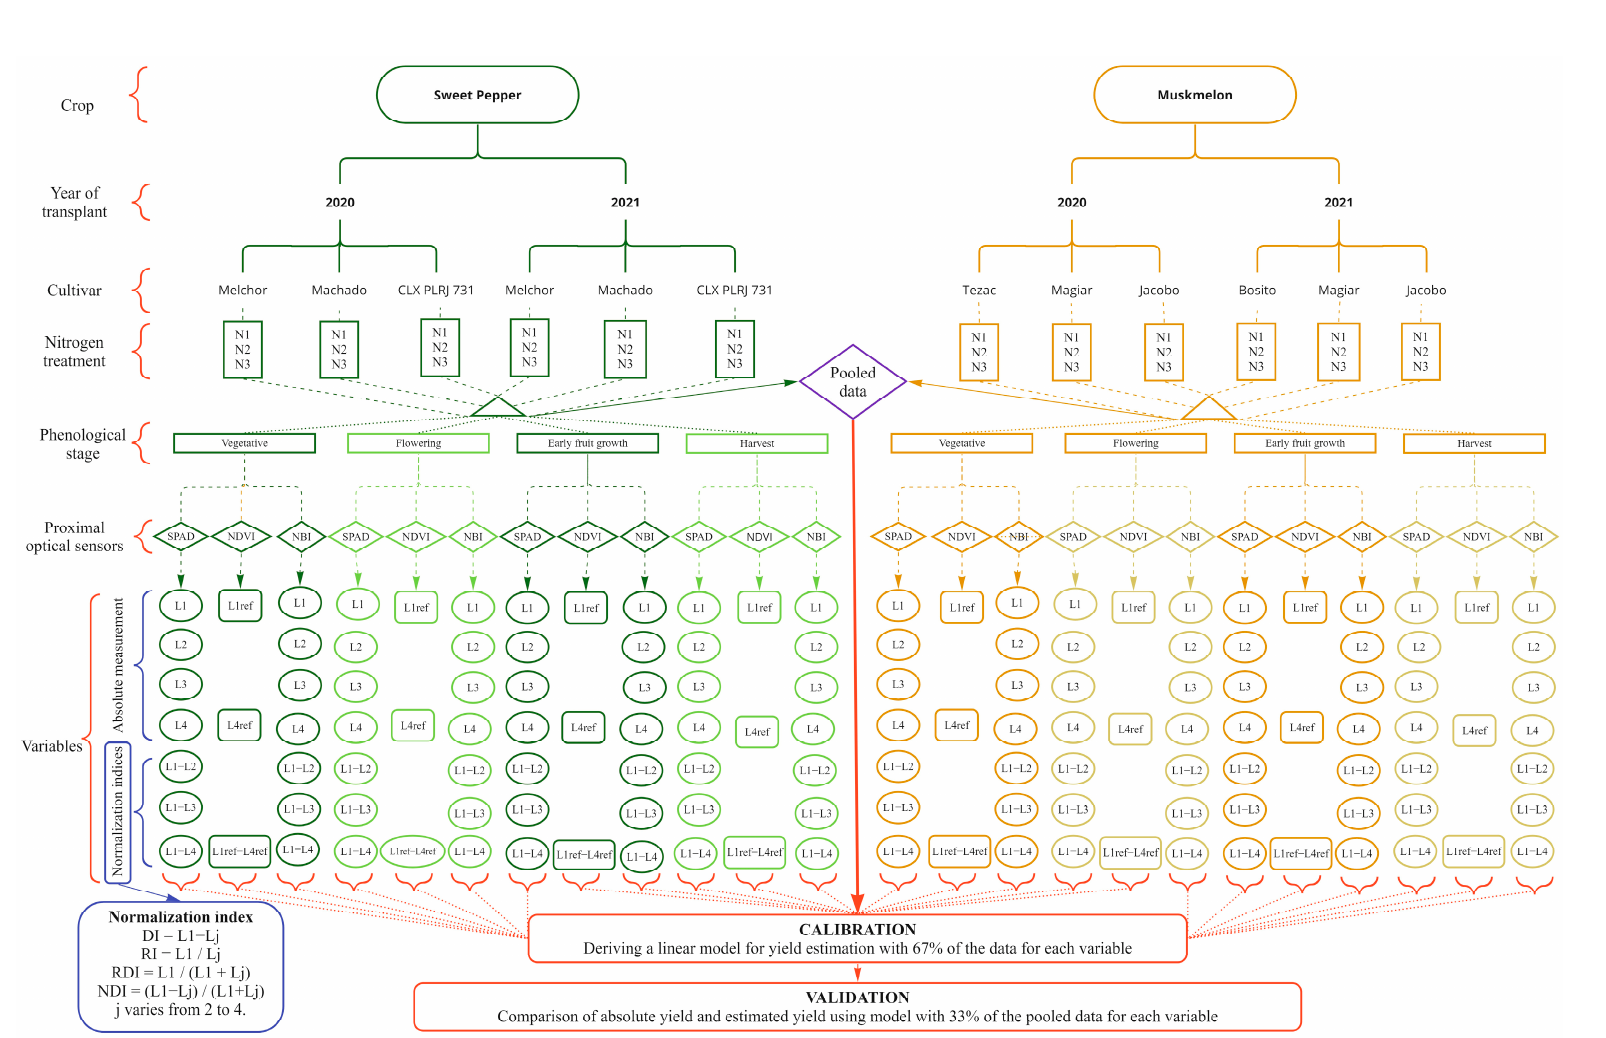
Figure 1. Research diagram including the independent variables, dependent variables, calibration, and validation information. N1 is the very deficient N treatment, N2 is the deficient N treatment, and N3 is the conventional N treatment. L1 (L1ref), L2, L3 and L4 (L4ref), refer to the latest (most recent) second, third and fourth fully expanded leafs, respectively.